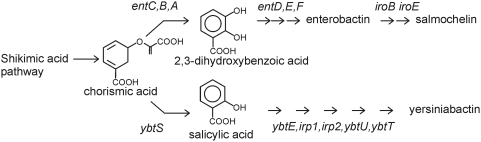
Biosynthesis of siderophores associated with recurrent UTI depends on chorismic acid utilization.